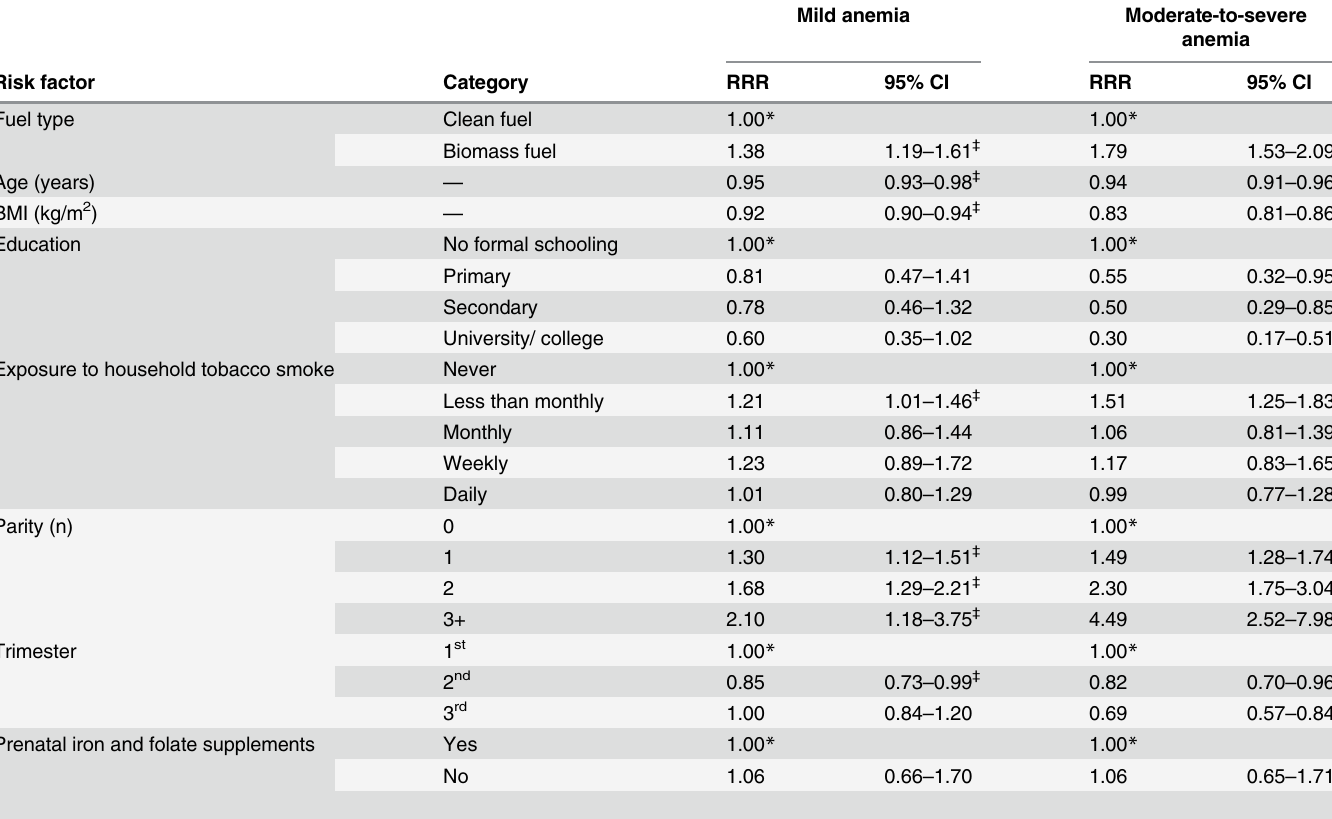
Table 3. Multivariable analysis of risk factors for anemia in pregnant women in Nagpur, India, 2011 – 2013: multivariable, multinomial logistic re- gression